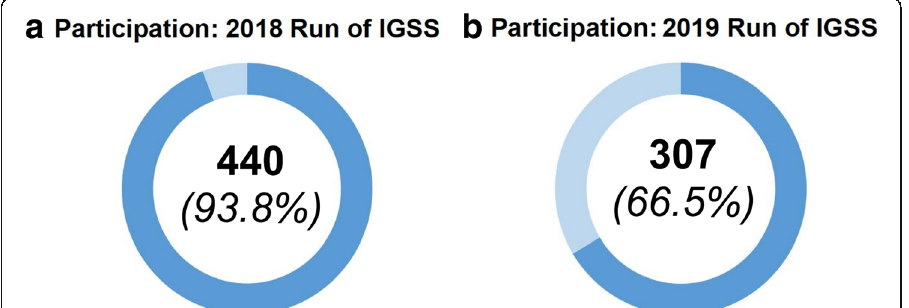
Fig. 1 A Number of students who completed at least one grammar test in 2018 run of IGSS. B: Number